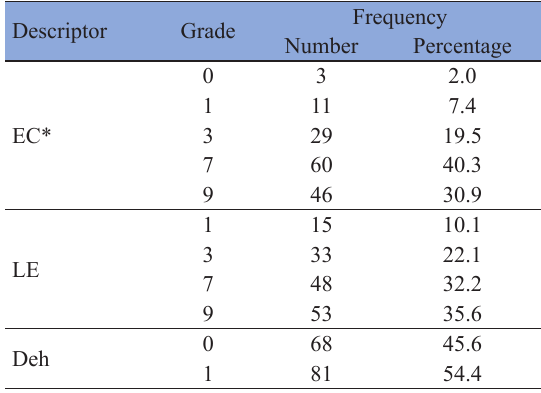
Table 5. Frequencies of the grades of the qualitative descriptors used to characterize 149 achiote